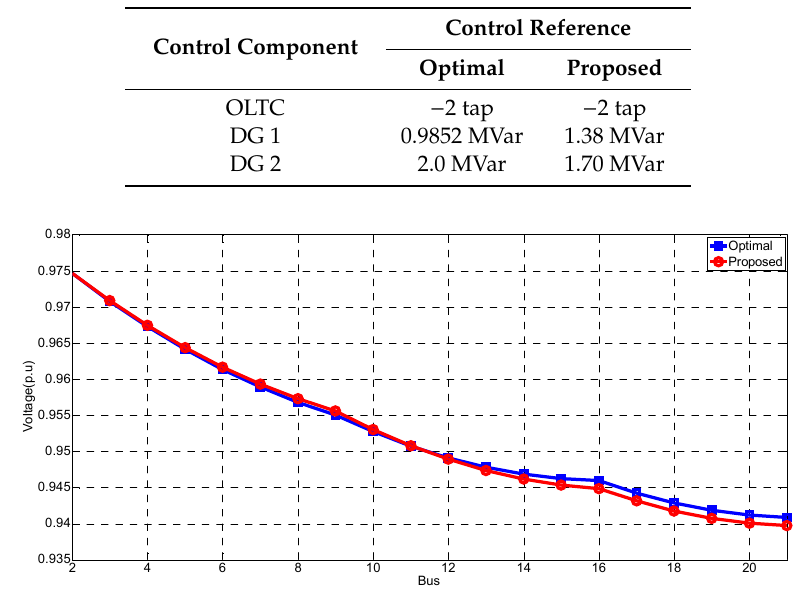
Table 3. Simulation results of the tap position and reactive power for CVR in case 1.